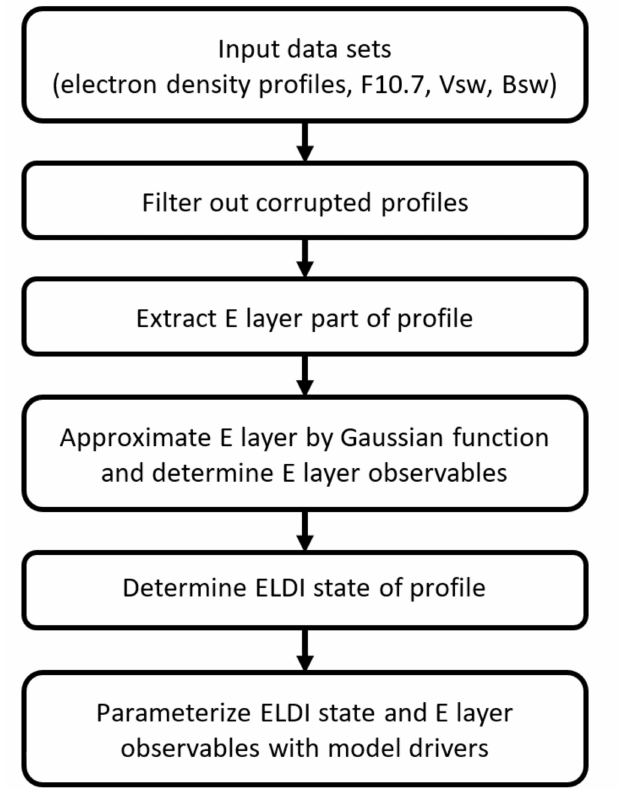
Figure 1. Flowchart of the data pre-processing